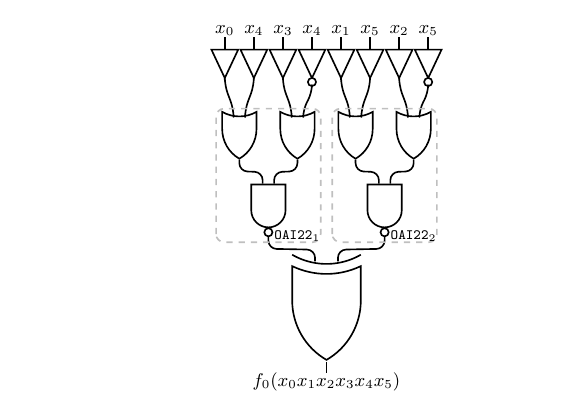
Figure 8: Another optimized circuit for the representative function f 0 in Example